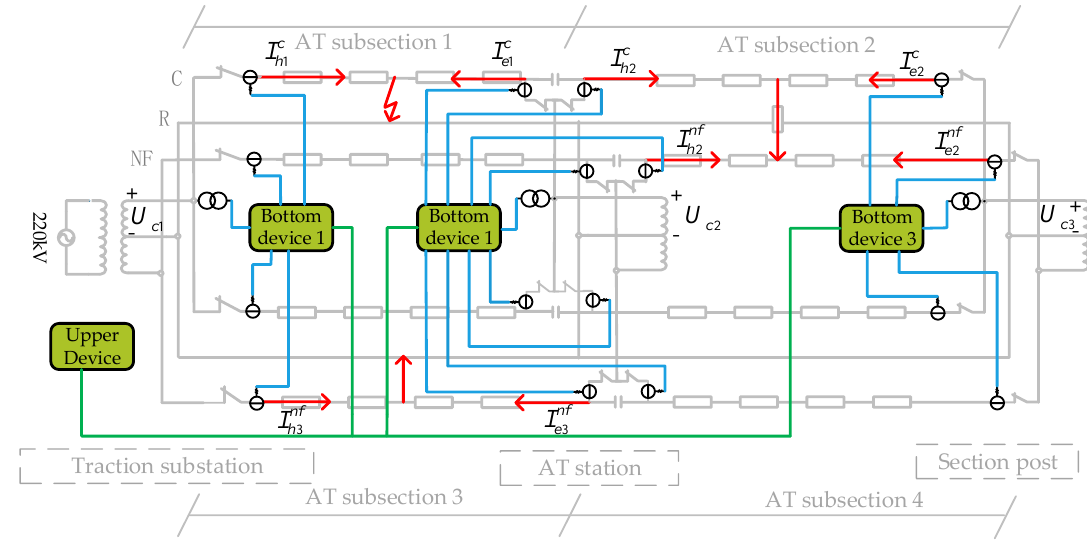
Figure 18. Simplified circuit of the experimental platform for the novel segmental all parallel AT TPSS.